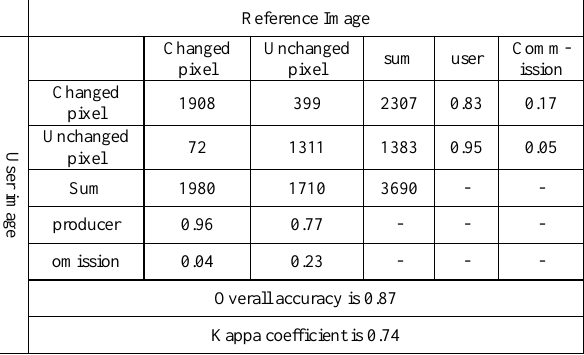
Table 6. Error matrix of pixel-base method with CV